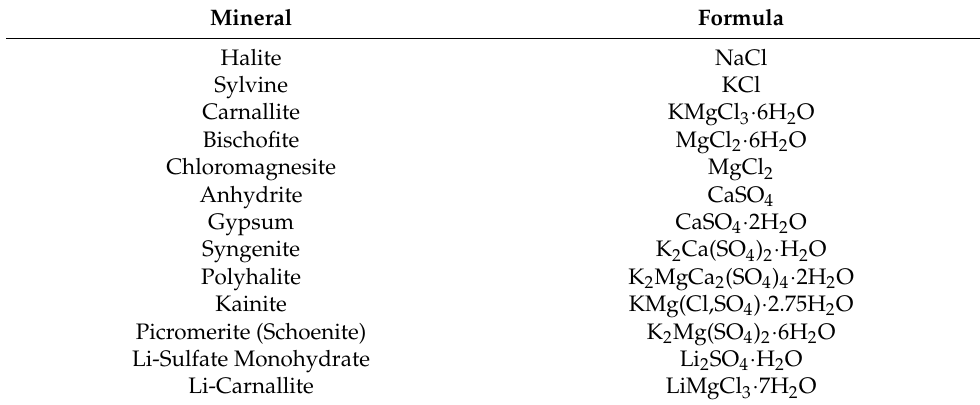
Figure 43. Cluster analysis identifying different clusters of evaporites from a lithium brine deposit ( n -43) and the relevant dendrogram, *** indicates the most representative scan of a cluster, + indicates the two most different scans within one cluster. For the set of 43 samples, 13 different mineral phases are identified using XRD, Table 4. Main lithium containing phases are Li-Carnallite and Li-Sulfate Monohydrate. Table 4. Minerals identifies in the brine samples investigated.